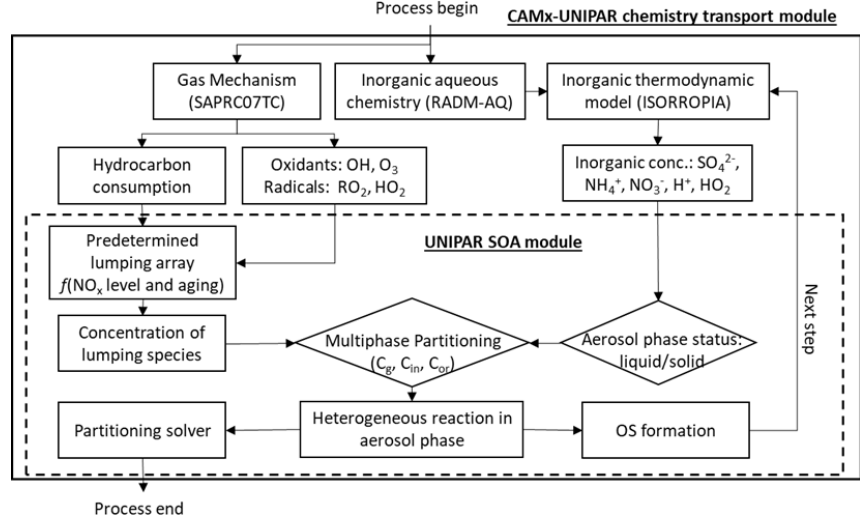
Figure 1. Scheme of CAMx v7.1 chemistry transport model integrated with the UNIPAR secondary organic aerosol